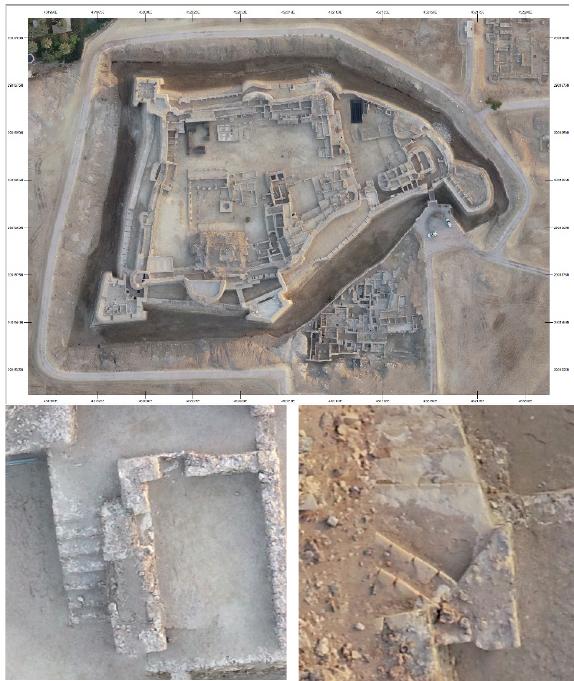
Figure 12. Orthoimage of the site and zoomed views.